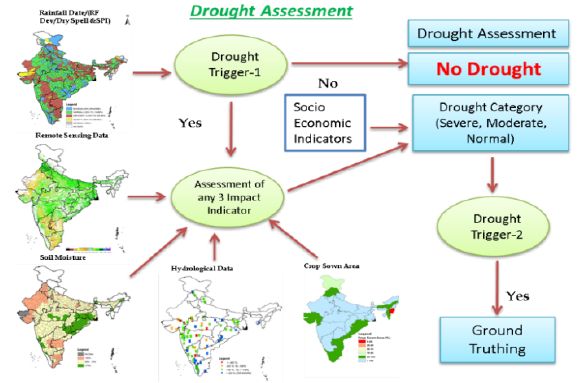
Figure 2: Flow Chart of Methodology for Drought assessment